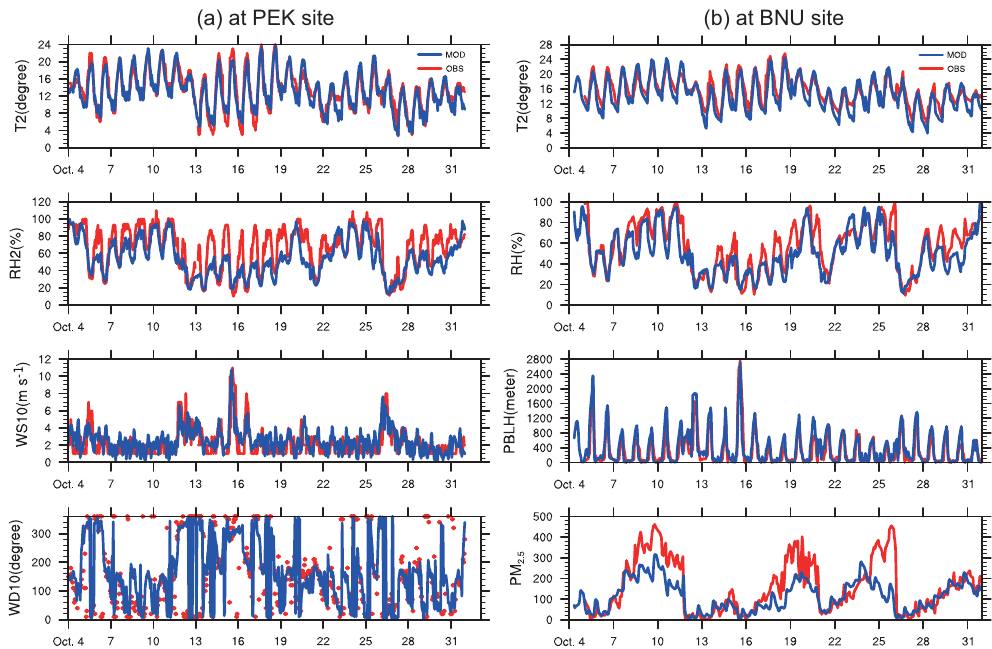
Figure 3. Time series of observed and simulated meteorological parameters and PM 2 . 5 at the (a) PEK and (b) the BNU sites (in local time). Time starts at 00:00 local time. Parameters: T2 – temperature at 2m (degree), RH2 – relative humidity at 2m (%), WS10 – wind speed at 10m (ms − 1 ), WD10 – wind direction at 10m (degree), and PBLH – planetary boundary layer height